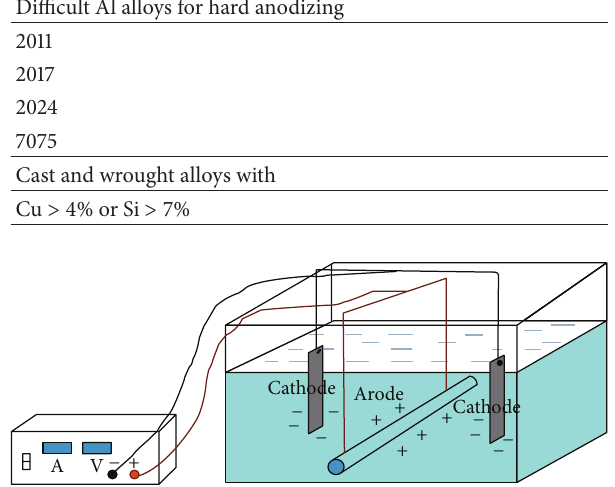
Table 2: The list of the aluminum alloys which should be avoided to hard anodizing [83].